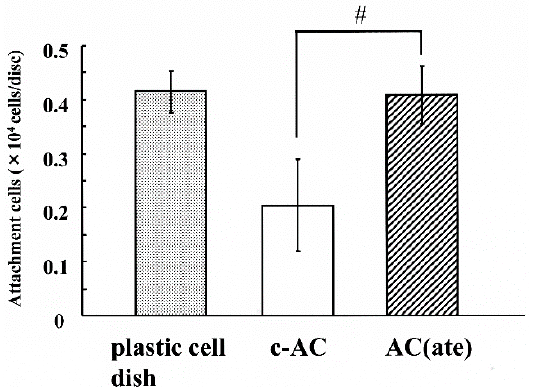
Figure 1. Initial attachment of cells to the surface of conventional apatite cement (c-AC), AC containing atelocollagen (AC(ate)) and plastic wells. The numbers of MC3T3-E1 cells with all of the specimens were determined after 5 h of culturing. Results are shown as the mean ± standard deviation ( n = 5). # Significant difference as compared to c-AC (Student’s t -test: p < 0.05).